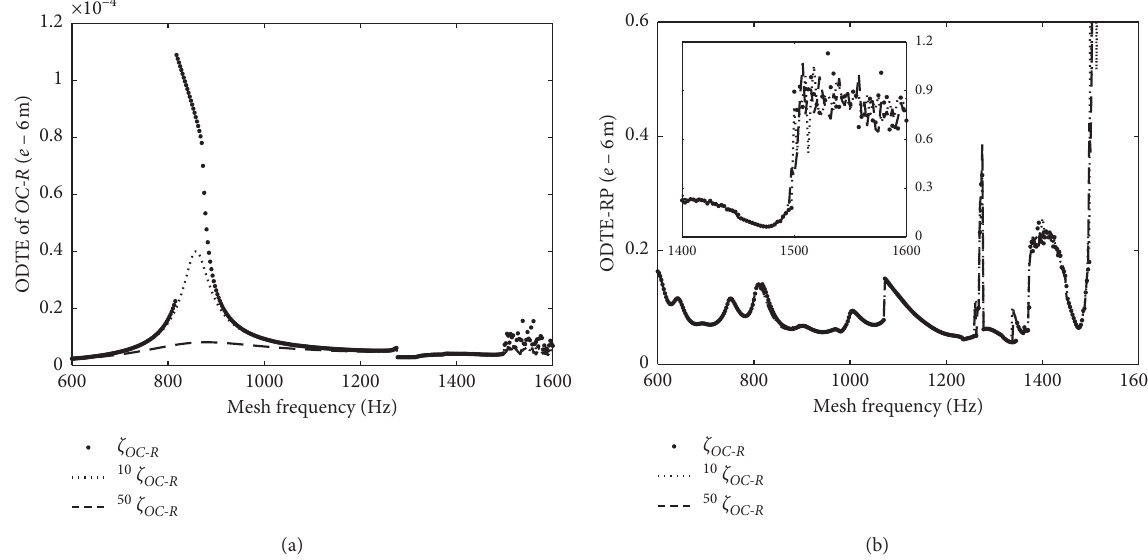
Figure 14: Nonlinear dynamics of the unit as damping ratio of SOWC-R changed: vibration characteristics of (a) SOWC-R and (b) RP.